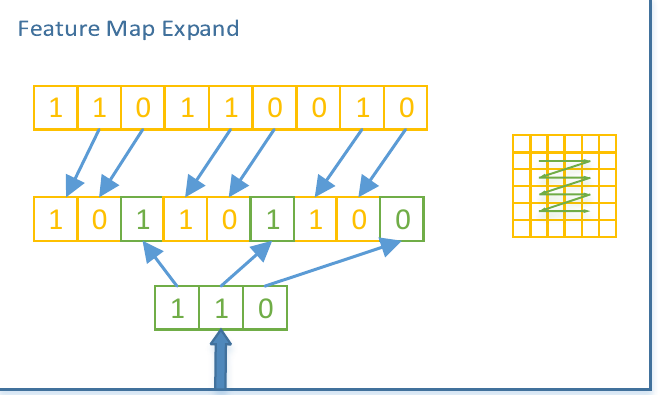
Figure 5. The Expansion Block emulates the sliding filtering process used by the small convolution kernel on the feature map.